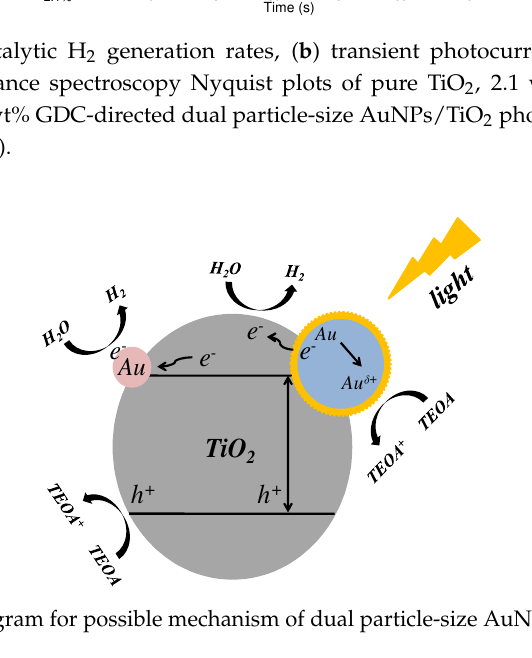
Figure 9. Schematic diagram for possible mechanism of dual particle-size AuNPs/TiO 2 composites for H 2 evolution. 4. Conclusions In summary, we successfully synthesized a 2.1 wt% dual particle-size AuNPs/TiO 2 composite and investigated the synergistic effects of the two different AuNPs size distributions on photocatalytic H 2 production enhancement. The 2.1 wt% dual particle-size AuNPs/TiO 2 composites not only display a H 2 evolution efficiency 281 times greater than TiO 2 alone, but also outperform the